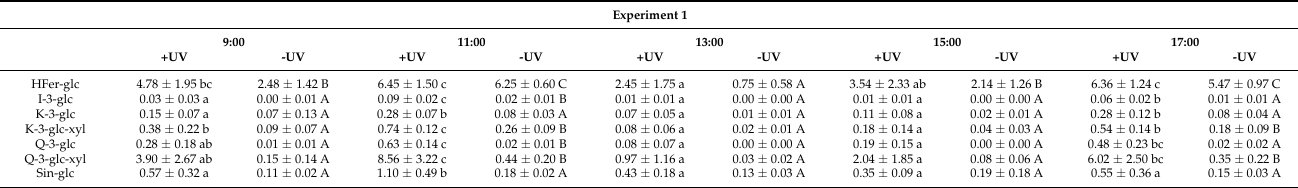
Table 3. Soluble flavonoid glycosides and hydroxycinnamic acids in okra grown under different UV conditions on day seven at different times of the day in Experiment 2 (targeting changes in diurnal rhythm due to transfer to the opposite UV condition). Different letters represent significant differences between the UV conditions at p ≤ 0.05. I: isorhamnetin; K: kaempferol; Q: quercetin; glc: glucose; xyl: xylose; HFer: hydroxyferuloly; Sin: sinapoyl. Experiment 2